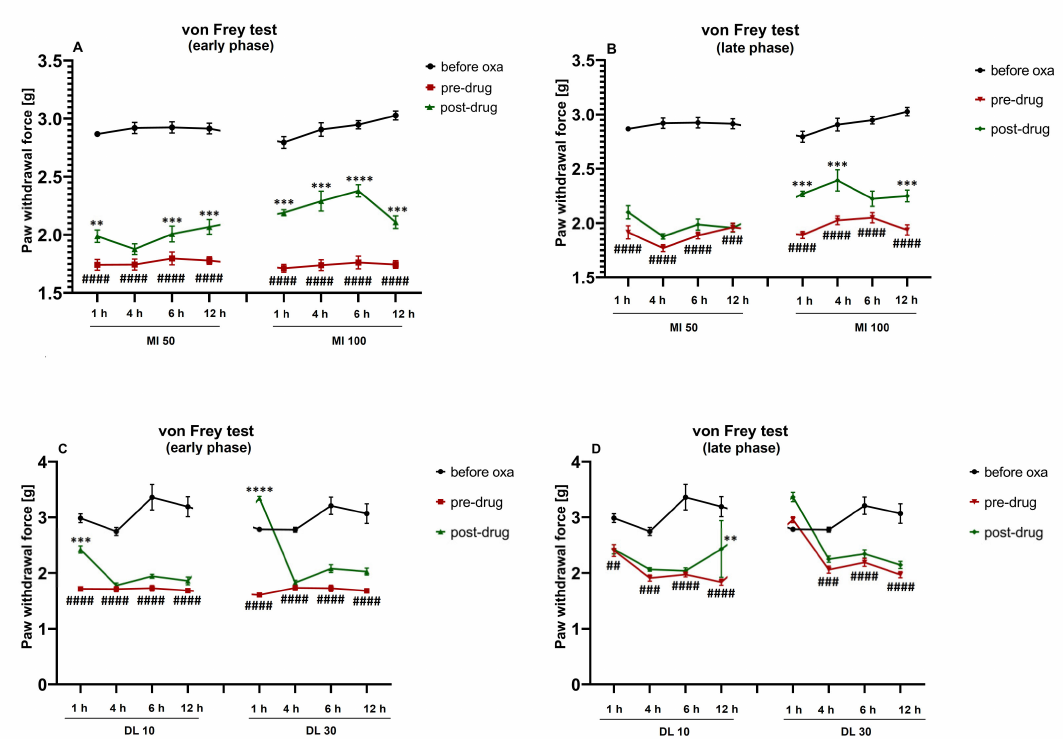
Figure 4. Duration of the antiallodynic effect of single-dose minocycline and duloxetine, each used alone, on the pain threshold in oxaliplatin-treated mice. Effect of minocycline (50, 100 mg/kg, i.p.) on tactile allodynia measured in the von Frey test assessed 1 h, 4 h, 6 h and 12 h after administration, on the day of oxaliplatin administration ( A ) and 7 days after oxaliplatin ( B ). Effect of duloxetine (10, 30 mg/kg, i.p.) on tactile allodynia measured in the von Frey test assessed 1 h, 4 h, 6 h and 12 h after administration, on the day of oxaliplatin administration ( C ) and 7 days after oxaliplatin ( D ). The results are shown as the mean paw withdrawal threshold ± SEM for n = 10. Statistical analysis: repeated measures ANOVA followed by Tukey’s post-hoc comparison. Significance: ## p < 0.01, ### p < 0.001, #### p < 0.0001 vs. before oxaliplatin; ** p < 0.01, *** p < 0.001, **** p < 0.0001 vs. pre-drug paw withdrawal threshold. Abbreviations: MI—minocycline, DL—duloxetine. In the figure titles ‘early phase’ ( A , C ) and ‘late phase’ ( B , D ) mean two time points at which the measurements were taken (day of oxaliplatin administration and day 7 after a single-dose oxaliplatin administration, respectively). Numerical values of the paw withdrawal thresholds ± SEM presented in this figure are shown in the Supplementary Materials (Table